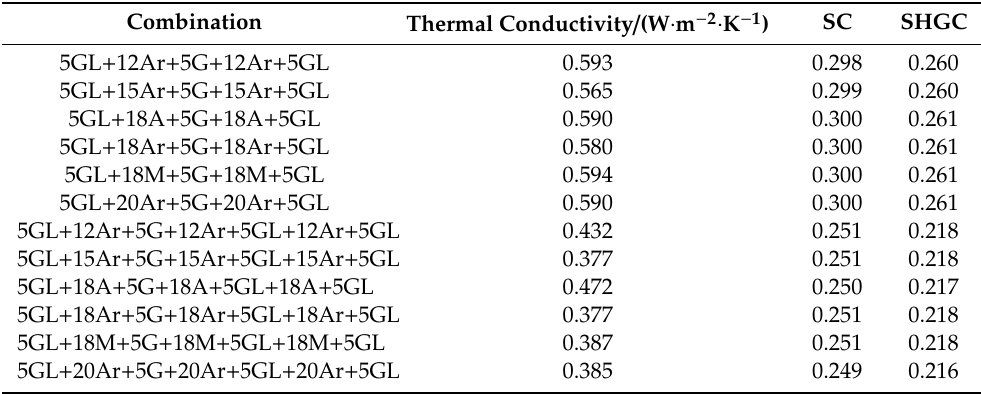
Table 6. Heat transfer coe ffi cients of di ff erent window